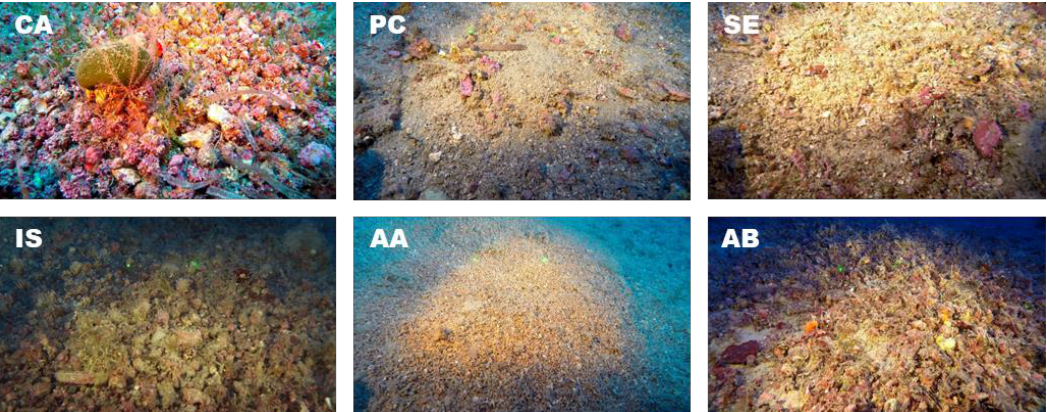
Figure 4. Representative video frames of the explored sites. In each video frame, the 2 green parallel laser beams indicate a fixed distance of 14.5 cm. CA, Capri; PC, Punta Campanella; SE, Secchitiello; IS, Ischia; AA, Acciaroli A; AB, Acciaroli B.